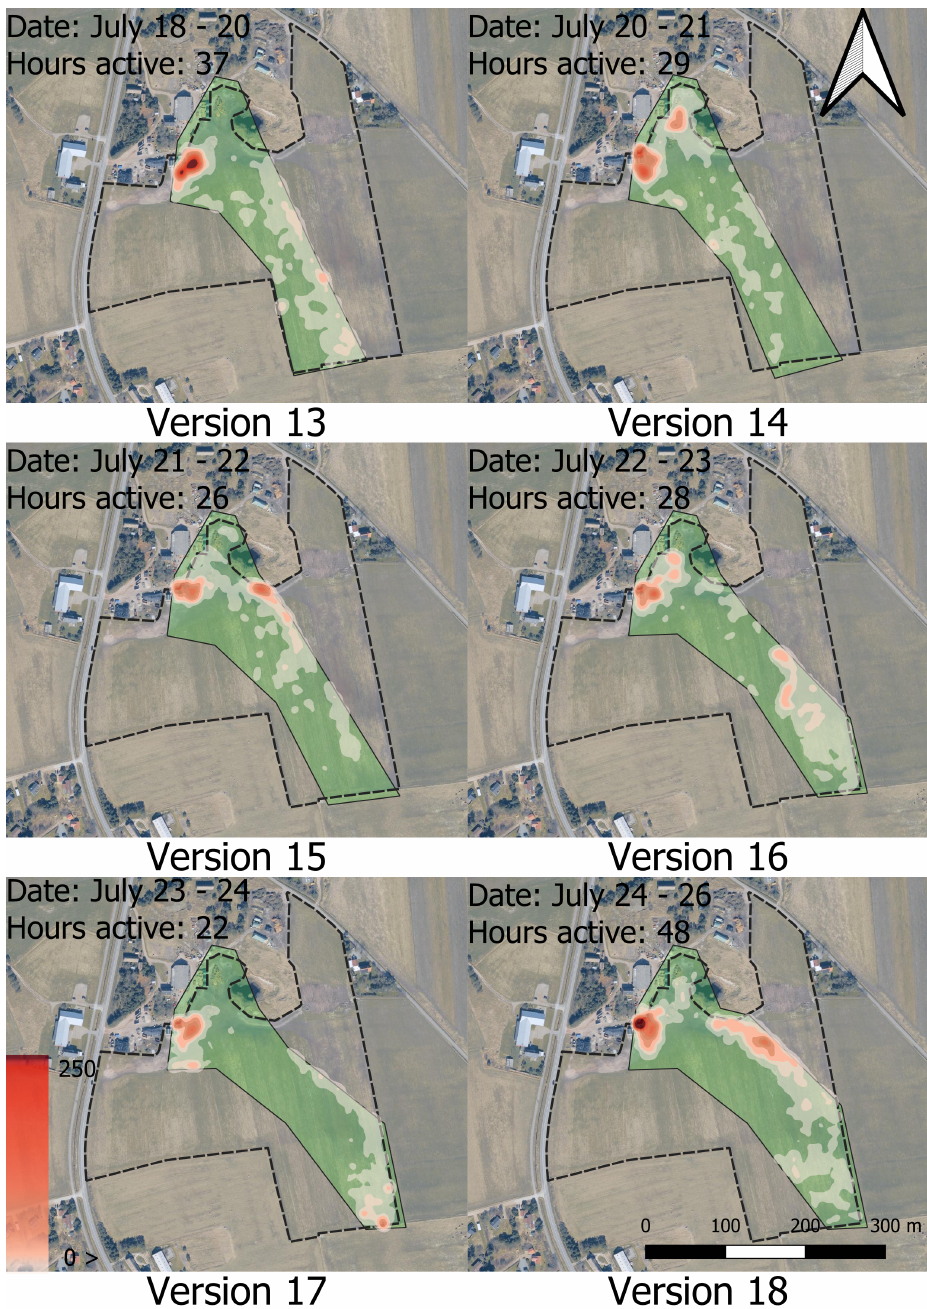
Figure A12. Heatmap series 3 visualising all Poll messages sent during the period from 18 July to 26 July. The green area shows the virtual enclosure area to which the bull calves were limited. The white to red colour indicates the number of Poll messages within a 10 m radius. The brightest colour represents the areas with the lowest density of Poll messages, while the darkest colour represents the areas with 250 or more Poll messages within the radius. The coordinates of the upper left corner of the map frame are 55°25 (cid:48) 23.131 (cid:48)(cid:48) E 8°23 (cid:48) 53.531 (cid:48)(cid:48) N. Contains data from the Agency for Data Supply and Infrastructure, Forårsbilleder Ortofoto-GeoDanmark, December